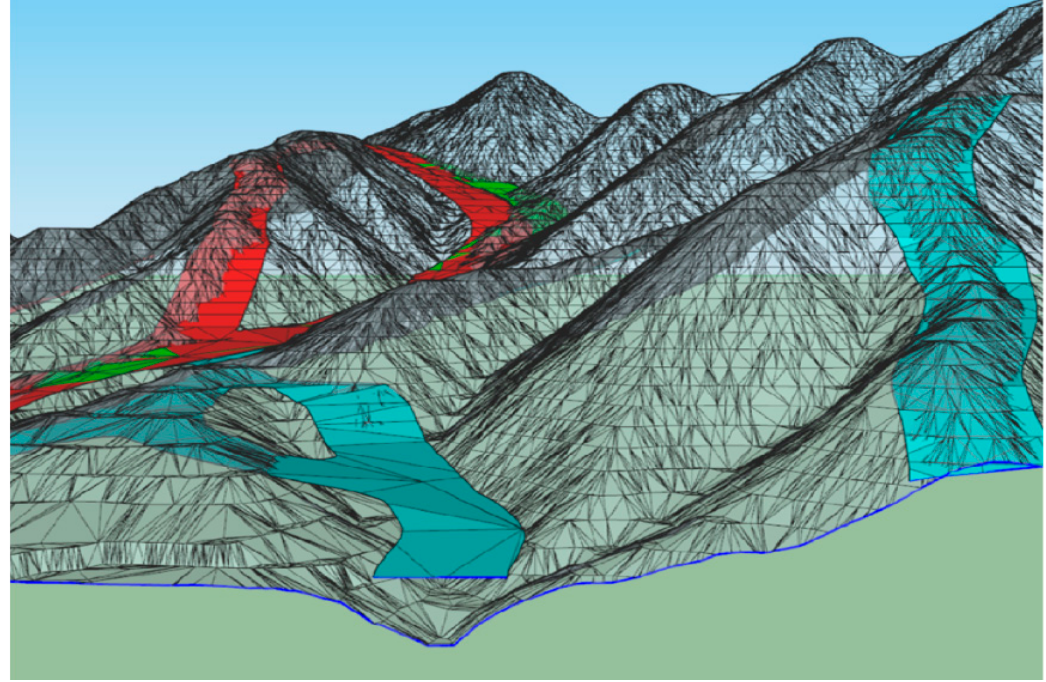
Figure 13. The combined 3D visualization of ski track models.